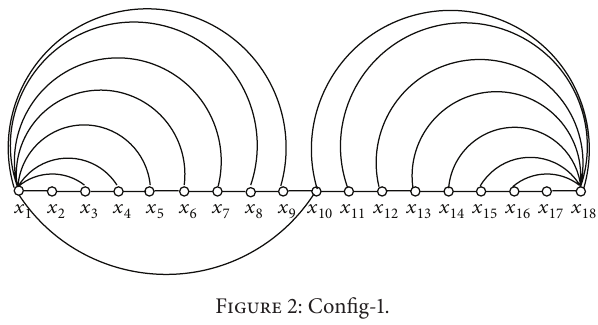
Figure 2: Config-1.